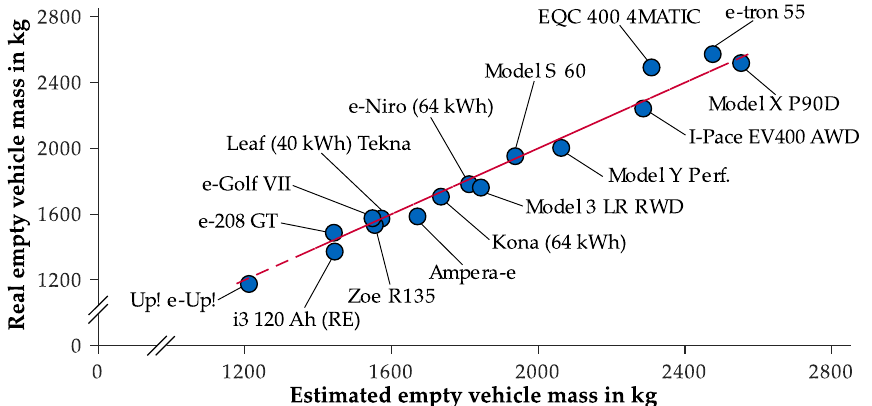
Figure 6. Comparison of estimated and real empty vehicle mass presented as a whole model plot.